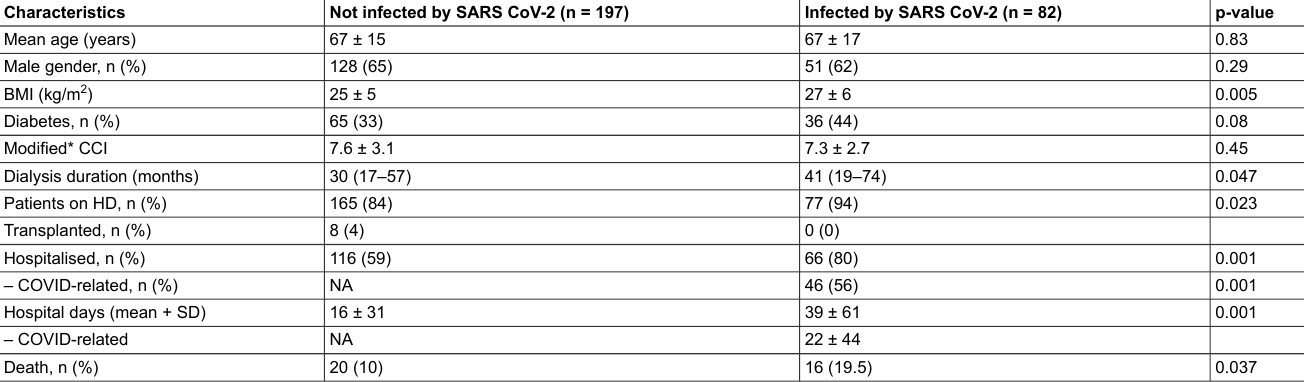
Table 1: Baseline characteristics of patients on maintenance dialysis by infection status (Geneva area March–December 2020). Characteristics